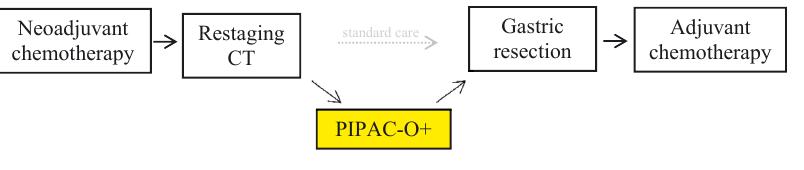
Figure 1: PIPAC-O + pathway.